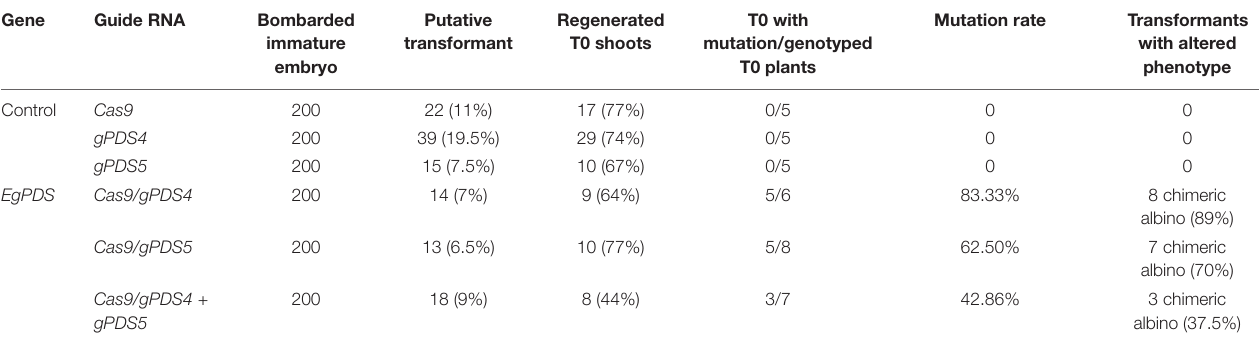
TABLE 1 | The efficiency of clustered regularly interspaced short palindromic repeat (CRISPR)/CRISPR-associated protein 9 (Cas9) and guide RNA (gRNA) transformation targeting phytoene desaturase ( EgPDS) gene in oil palm and the phenotypes of the transgenic plants. Gene Guide RNA Bombarded Putative immature embryo